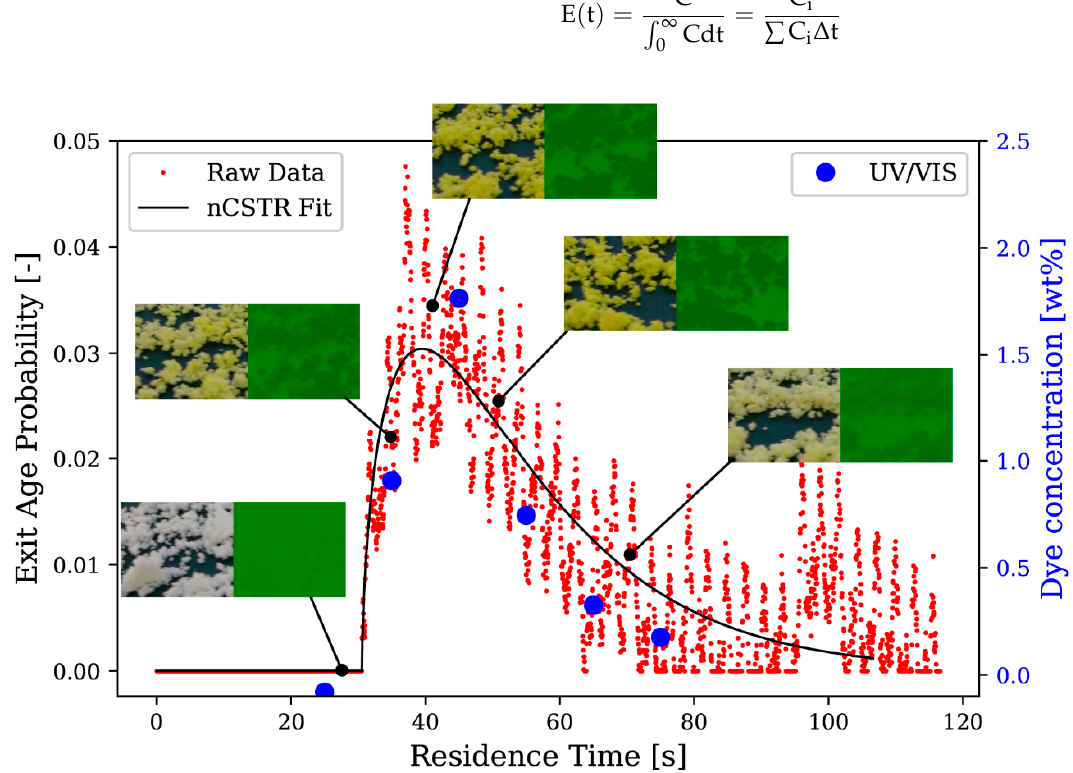
Figure 2. Schematic overview of video frame evaluation in a region of interest and correlation of volumetric probability distribution (q 3 ) by continuous camera measurements (red dots) and sample Tartrazine ratio by UV/VIS spectral measurements (blue dots). nCSTR, continuously stirred tank reactor model.